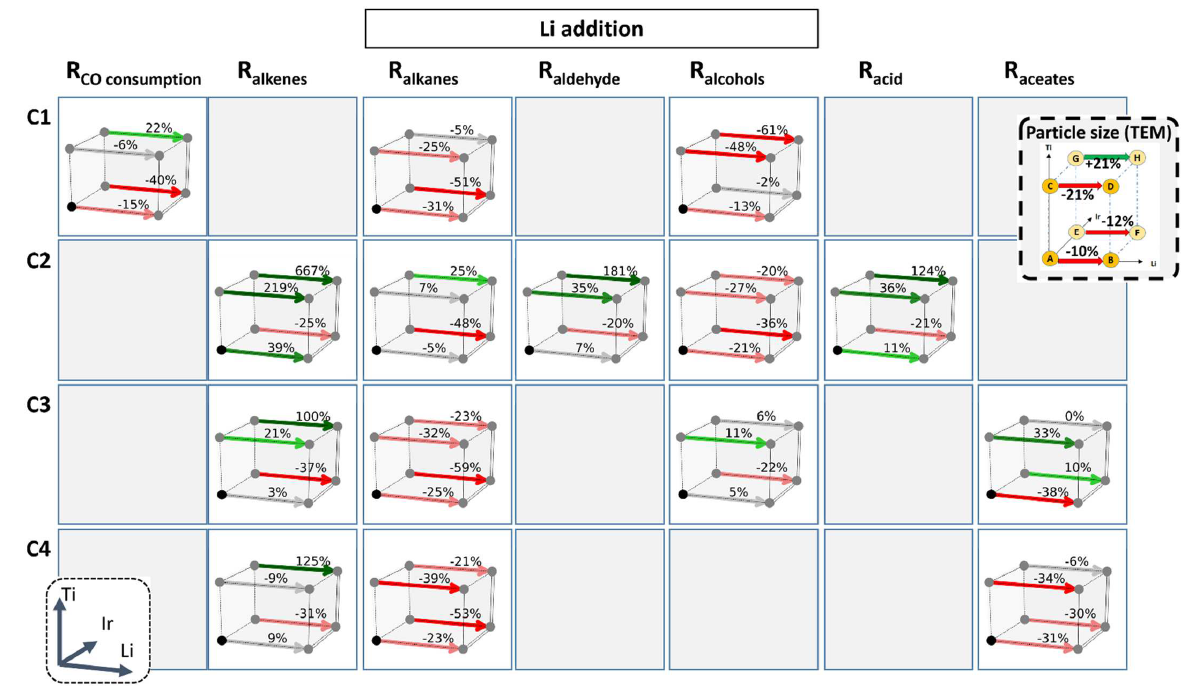
Figure 6. The studied effect of target promoter Li in Exp 1 (T = 270 °C, P = 50 bar, total flow = 43 mL/min, H 2 :CO = 48:22%V). The color of the arrows and the cubes are sorted as in Figure 5. The arrows show the compared catalyst pairs, pointing towards the catalyst with added Li. The cube on the right shows the effect of Li addition on average particle size for the same catalyst pairs. A green arrow (increase of rate) is observed mostly for C2 products of catalysts’ pairs with Ti in their composition.